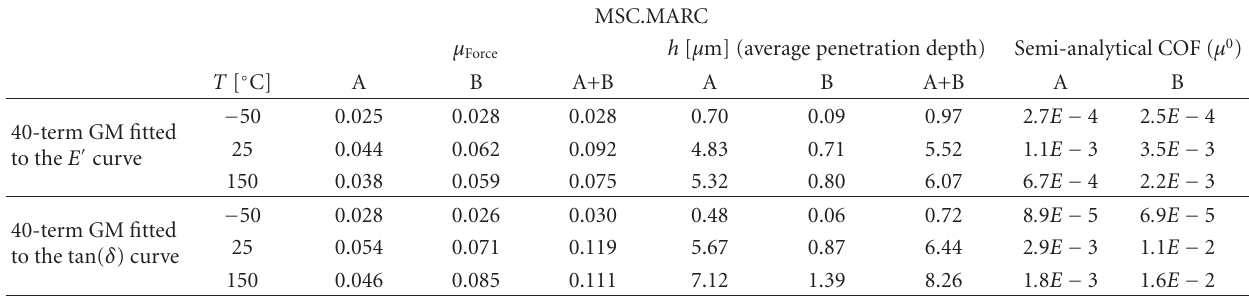
Table 3: Average, steady-state COFs and the average penetration depth at di ff erent temperatures in case of 40-term Maxwell-models ( μ interface = 0, GM: generalized